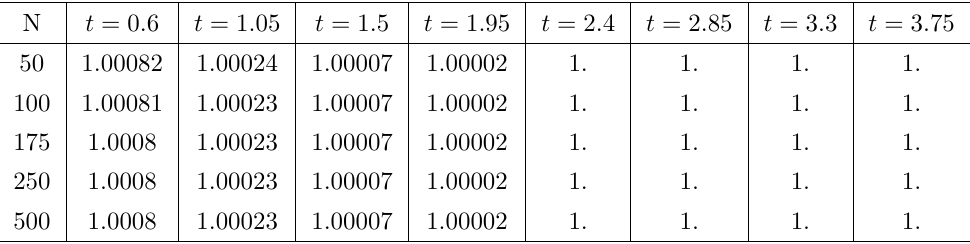
Table 14 . A comparison of the value of the correlation function at various di(cid:11)erent grid sizes. This data was calculated for a transverse separation of l = 0 : 5 in a charged thermalizing (cid:13)uid (dual to the relaxation towards a magnetic black brane geometry) (cid:26) = 0 : 78 (cid:26) e , B = 1 : 0 across (cid:27) = 0. As a result the derivative, g ( (cid:27) ) = dv=d(cid:27) , is an odd function g ( (cid:0) (cid:27) ) = (cid:0) g ( (cid:27) ). The rate of change of the timelike coordinate with respect to the non-a(cid:14)ne parameter for negative values of the parameter is minus the value for positive values of the